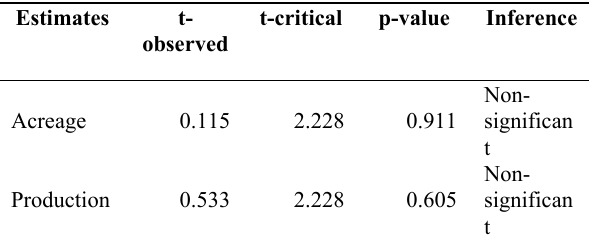
Table 4: State-level comparison of DES and FASAL Rapeseed & Mustard estimates using paired t-test (2017-18) The t-observed value falls under the acceptance region of normally distributed t-curve, hence null hypothesis (H 0 ) is accepted which indicates that DES and FASAL estimates are not significantly different which further ensure the capability of remotely sensed data for precise estimation of area and production at regional scale.